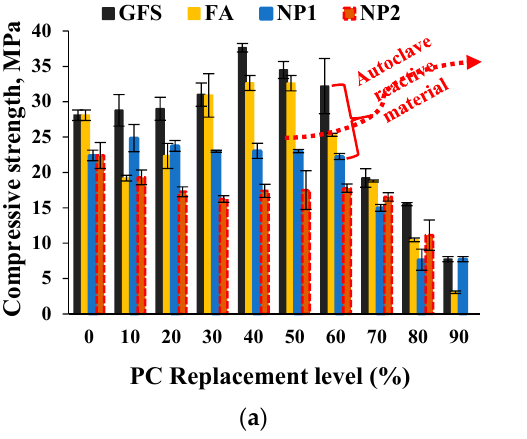
Figure 8. Effects of ( a ) GFS, FA, NP1, and NP2 replacement level on strength development and ( b ) replacing up to 40% NP1 and 40% NP2 by GSF on improving compressive strength.